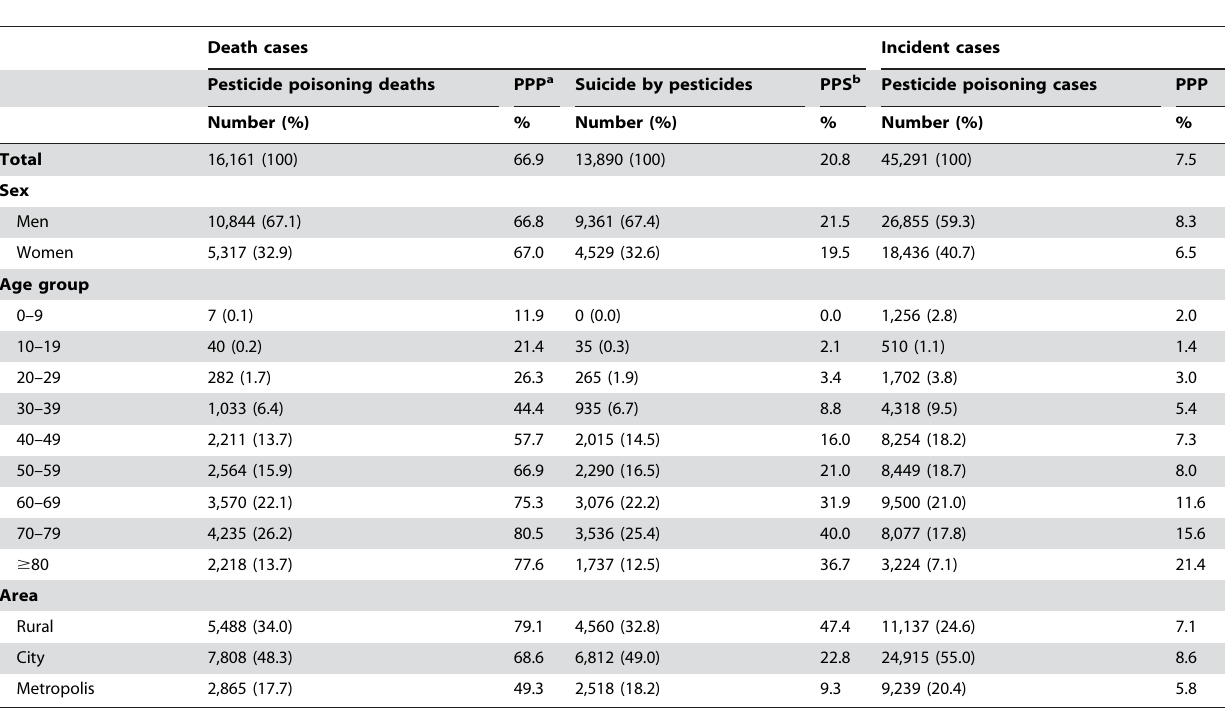
Table 2. The proportion of pesticide poisoning among total poisoning, and total suicides by sex, age, and area of residence in South Korea,